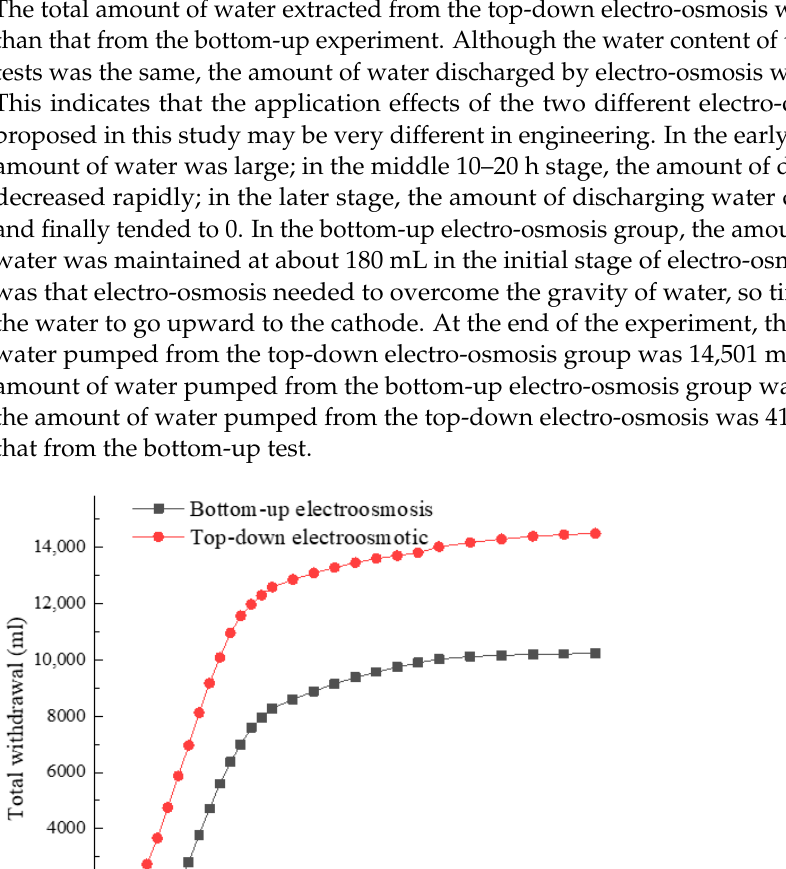
Figure 10. Variation curve of water discharge rate with time in electro-osmosis test. 3.3. Current Change Analysis The change in current in the process of the electro-osmosis test can better reflect the change in soil resistance and electro-osmosis energy consumption. Considering the elec- trical safety of the test, the power supply voltage of the two groups of tests was 36 V, and the initial current was 2.3 A. As shown in Figure 11, during the test, the current changes in the two groups of tests were basically the same. The overall trend was a rapid decline in the early stage, a slow decline in the middle and late stages, and finally tended to be gentle. The reason for this phenomenon was that in the early stage of electro-osmosis, the amount of discharging water and discharging rate were large. With the extraction of a large amount of water in the soil, the interface resistance of the pile–soil interface in the soil increased rapidly, resulting in a rapid decrease in the current in the soil. In the mid- dle and late stages, the amount of discharging water and discharging rate decreased, the 0